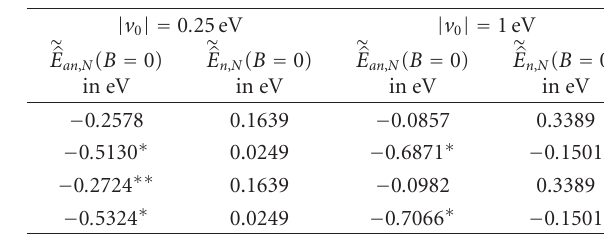
Table 1: The values of the anti-nodal and the nodal excitations for B = 0 for the disorder potential | v 0 | = 0 . 25eV and 1eV. All +, E B = 0) are above the value of μ = − 0 . 27eV. the values of n , N ( Therefore, the origin of the specific heat oscillations shown in